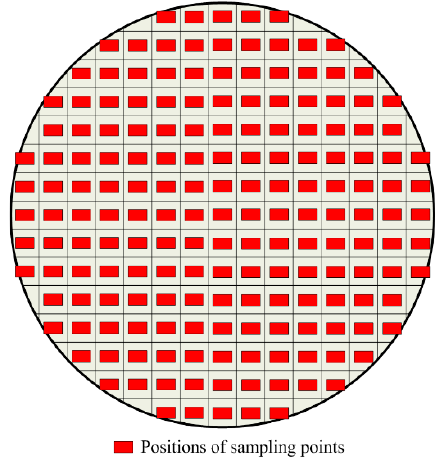
Figure 2. Positions of the 177 sampling points in the specimen of the briquette.